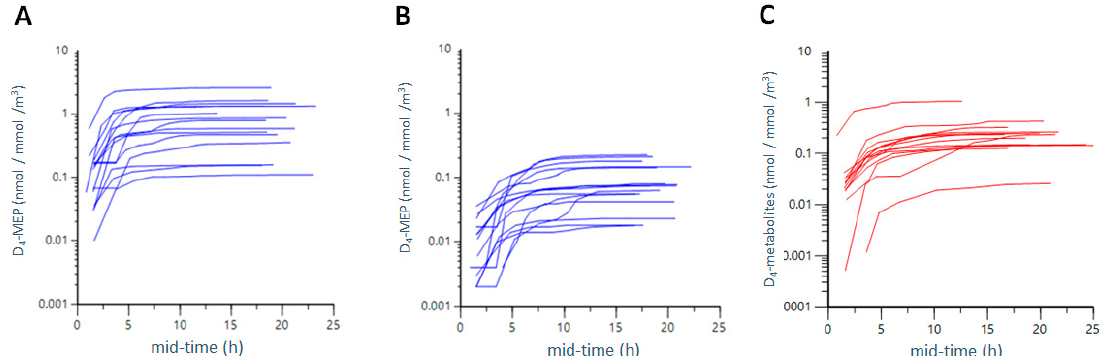
Figure 4. Total excreted dose after combined inhalation and dermal exposure to D 4 -DEP ( A ) and dermal exposure to D 4 -DEP only ( B ) as well as inhalation and dermal exposure of D 4 -DEHP ( C ). Cumulative excreted metabolite levels (in nmol) were normalised to air concentration of phthalate esters (in nmol/m 3 air volume). The y-axis is presented on a logarithmic scale, and time points are given in mid-time (mid time point of collection interval).